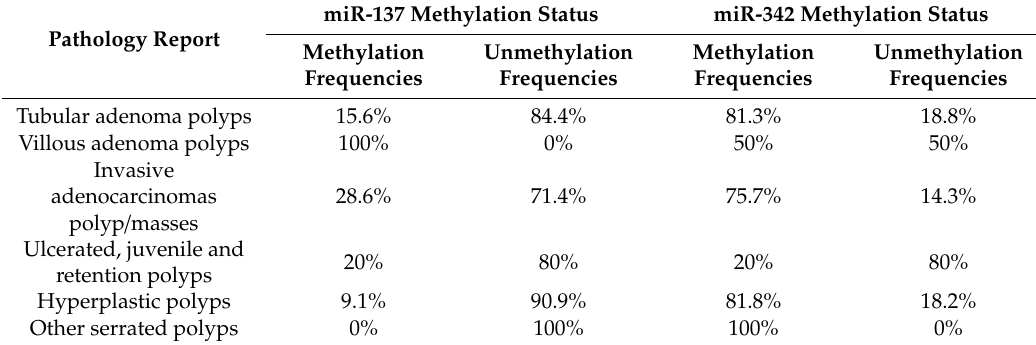
Table 5. Promoter methylation status of distinct colon lesions studied.